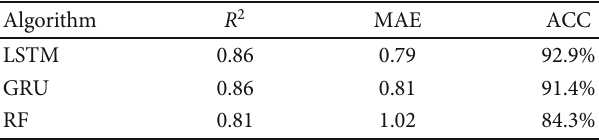
Figure 8: Comparison of prediction results of di ff erent algorithms. Table 2: Comparison of prediction indicators of di ff erent